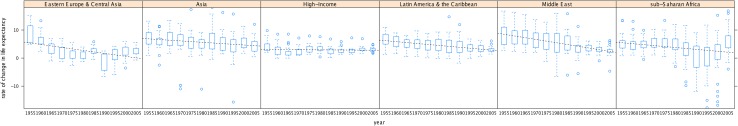
Regional change in life expectancy (months per year), 1950–2010.Note: mean regional trends in changes in life expectancy are indicated by the black dashed lines.